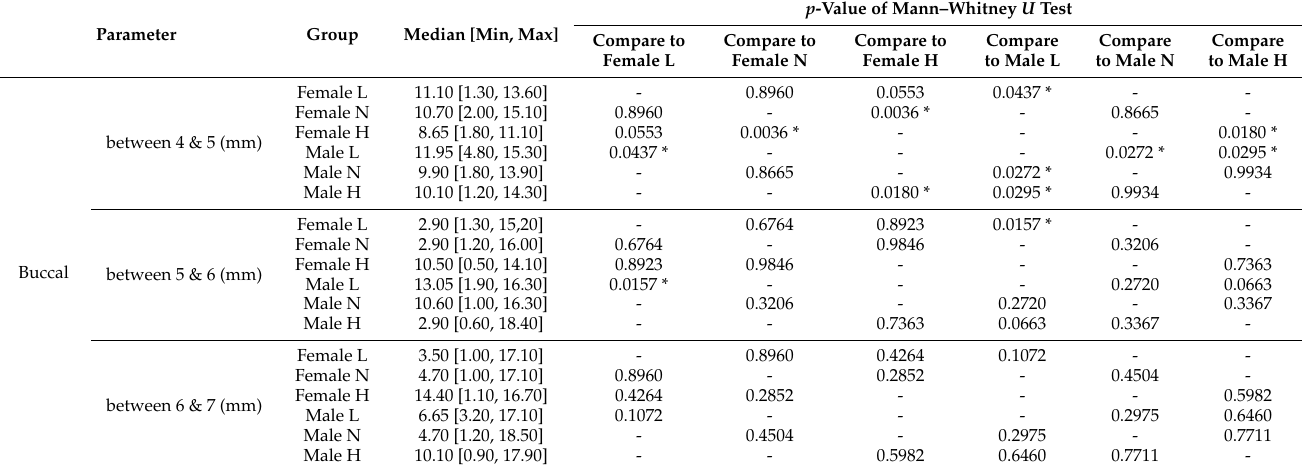
Table 7. The comparison of buccal and palatal alveolar bone thickness among groups at the level 10 mm above the alveolar crest. L: low-angle; N: normo-angle; H: high-angle. 4: first premolar, 5: second premolar, 6: first molar, 7: second molar. *: p <